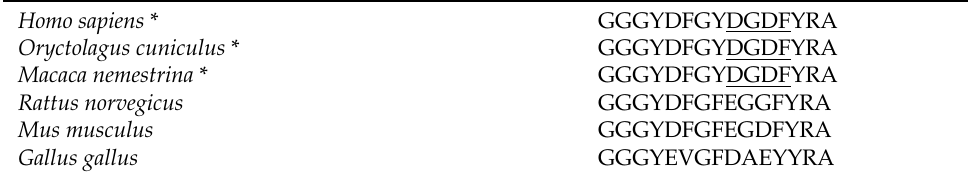
Table 1. Ct domain from six vertebrates.